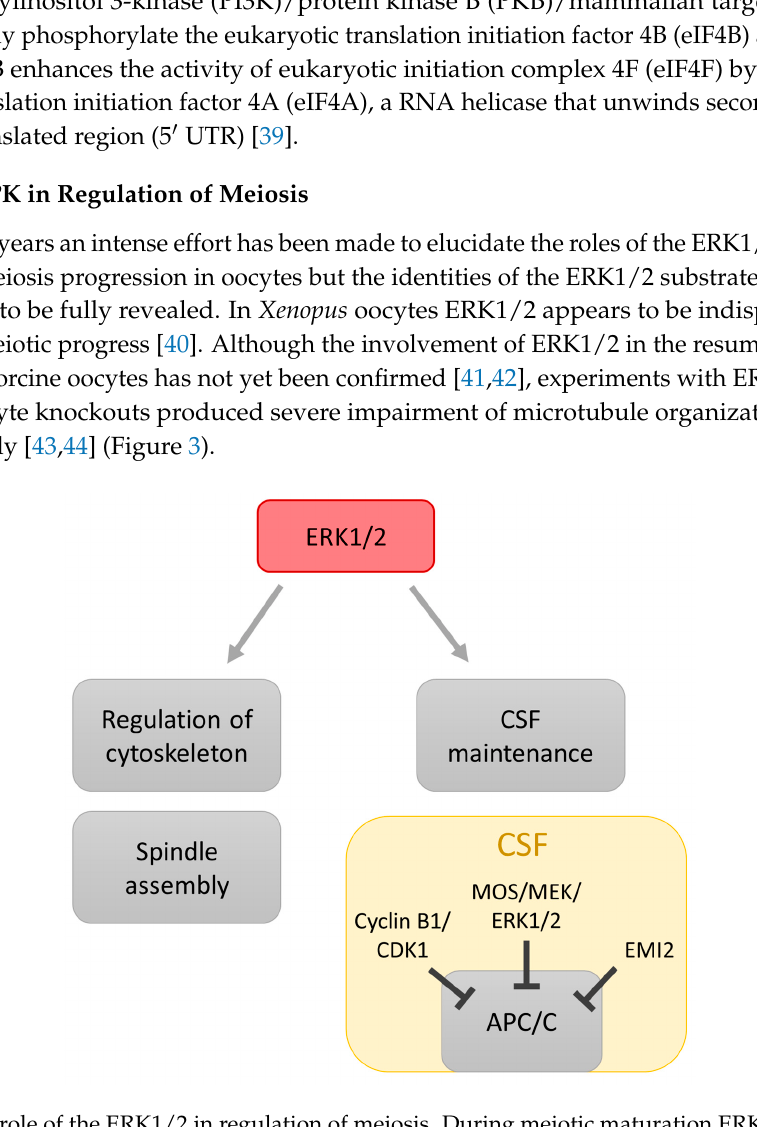
Figure 3. A role of the ERK1/2 in regulation of meiosis. During meiotic maturation ERK1/2 activity is essential for microtubule organization and meiotic spindle assembly (spindle depicted in green, chromosomes in blue). ERK1/2 is also an important component of the so-called cytostatic factor (CSF) protein complex, which prevents the exit of the oocytes from metaphase II stage via prevention of cyclin B destruction by anaphase-promoting complex/cyclosome (APC/C) complex. Moreover, downstream ERK1/2 effector p90 ribosomal S6 kinase (RSK) participates in maintaining the CSF arrest since RSK is involved in anaphase-promoting complex/cyclosome (APC/C) inhibition. Inhibitory modification of the kinases to APC/C is depicted as a blunt end